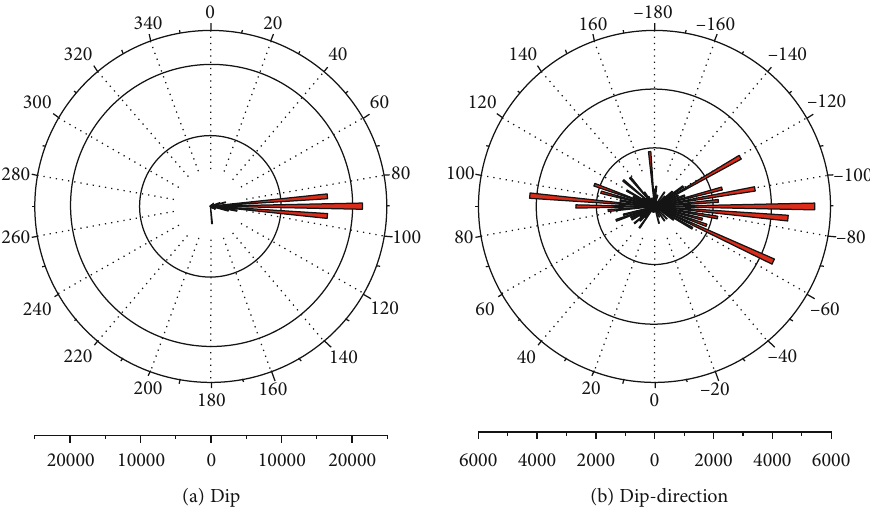
Figure 5: Distribution of the angles of the microfractures.